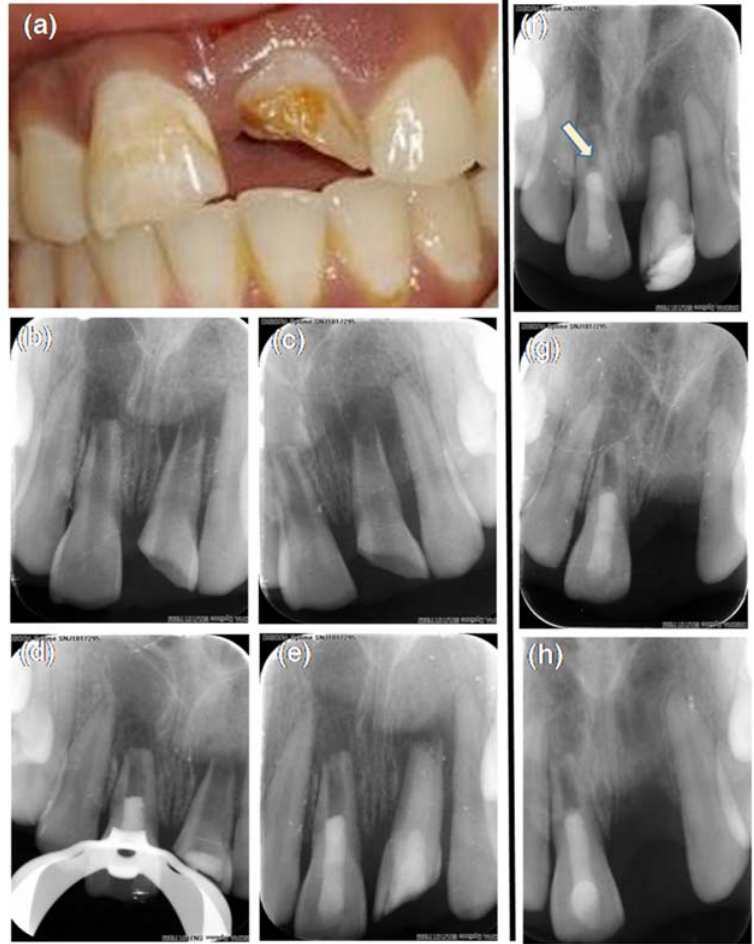
Figure 1. Intraoral periapical radiograph (IOPA) images of preoperative and a three-year follow up of REP in 11. ( a ) pre-operative photograph of maxillary central and lateral incisors; ( b , c ) pre-operative IOPA of teeth 11 and 21; ( d ) IOPA showing a coronal seal after placement of HAM in 11; ( e ) immediate postoperative IOPA of 11; ( f ) IOPA at a three-month follow up. The arrow is pointing to the calcific barrier above the Biodentine; ( g ) 19 month follow up IOPA; ( h ) three-year follow up IOPA.